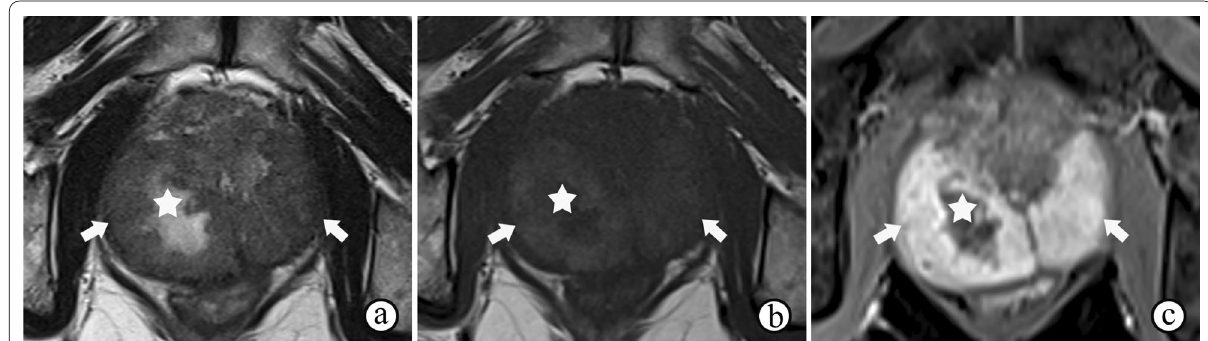
Fig. 4 Diffuse granulomatous prostatitis in a 67-year-old male. a T2WI shows diffuse swelling of bilateral peripheral zones and the signal intensity is diffusely decreased (arrow). b T1WI shows a diffusely increased signal intensity in the bilateral PZs (arrow). c DCE imaging shows a rapid enhancement of bilateral PZs (arrow). Note the central necrosis in the lesion ( ☆ )